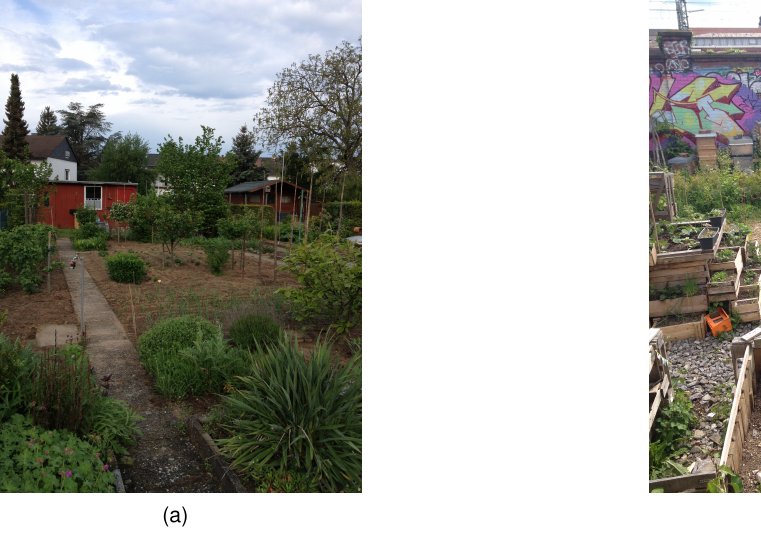
Figure 3. (a) Typical Kleingarten in the Federal State of Hessen (photography by Evelyn Gustedt). (b) Typical contempo- rary urban garden in the Federal State of Bavaria (photography by Anne